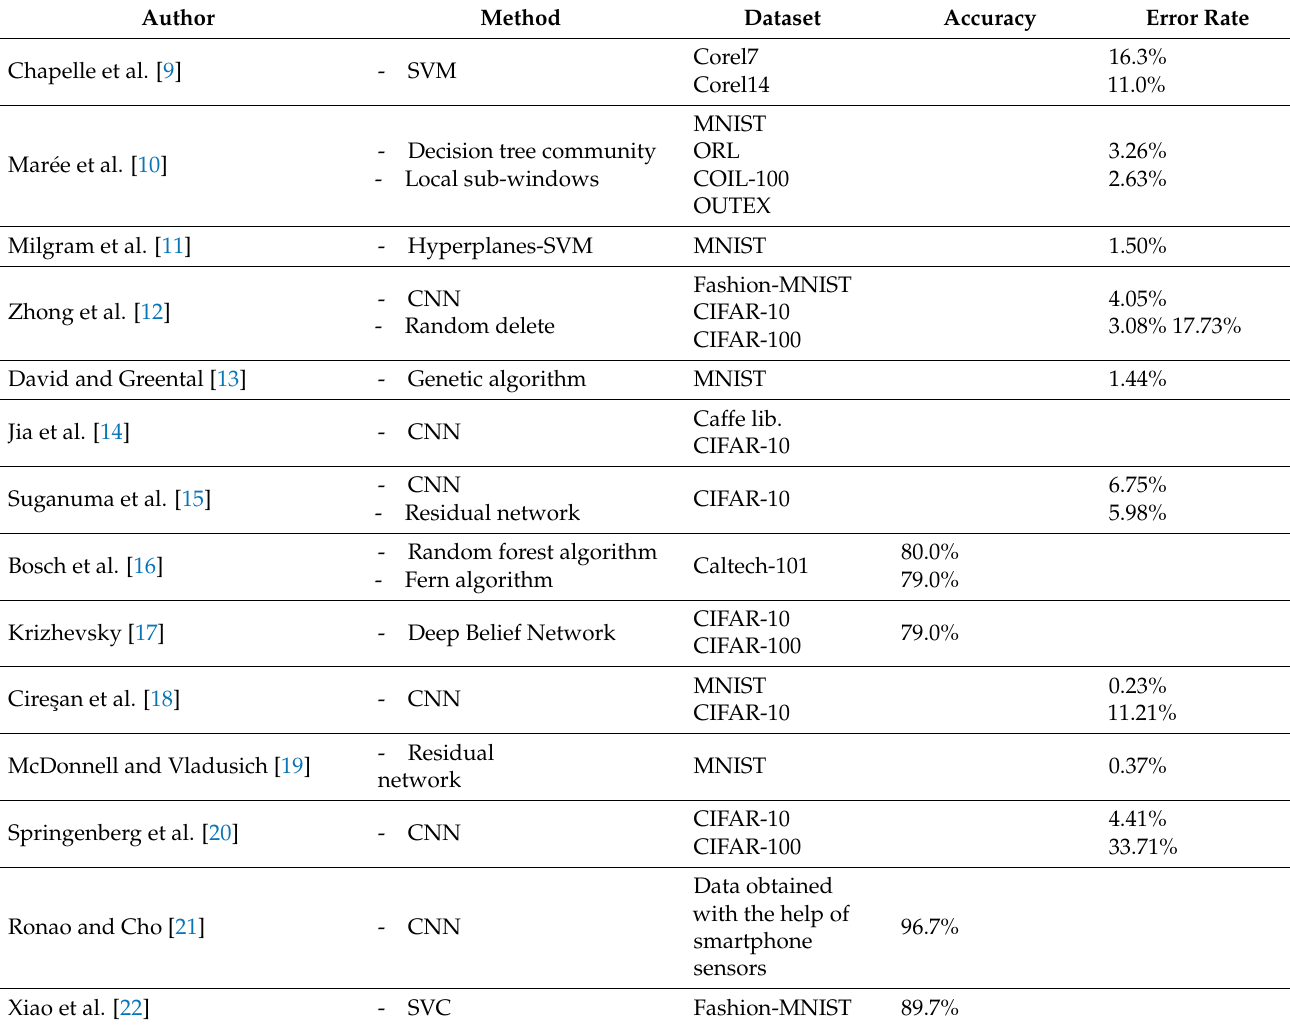
Table 1. Literature search of image classification studies using deep learning